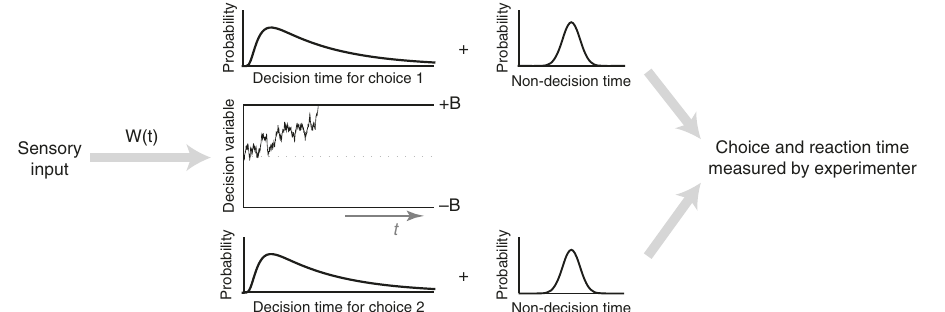
Fig. 2 The drift diffusion model (DDM) captures the core computations for perceptual decisions made by integration of sensory information over time. We use variants of this model and more sophisticated extensions to explore how the decision-making mechanism in fl uences psychophysical kernels. In DDMs, a weighting function, w ( t ), is applied to the sensory inputs to generate the momentary evidence, which is integrated over time to form the decision variable (DV). The DV fl uctuates over time due to changes in the sensory stimulus and neural noise for stimulus representation and integration. As soon as the DV reaches one of the two decision bounds ( + B for choice 1 and − B for choice 2), the integration terminates and a choice is made (decision time). However, reporting the choice happens after a temporal gap due to sensory and motor delays (non-decision time). Experimenters know about the choice after this gap and can measure only the reaction time (the sum of decision and non-decision times) but not the decision